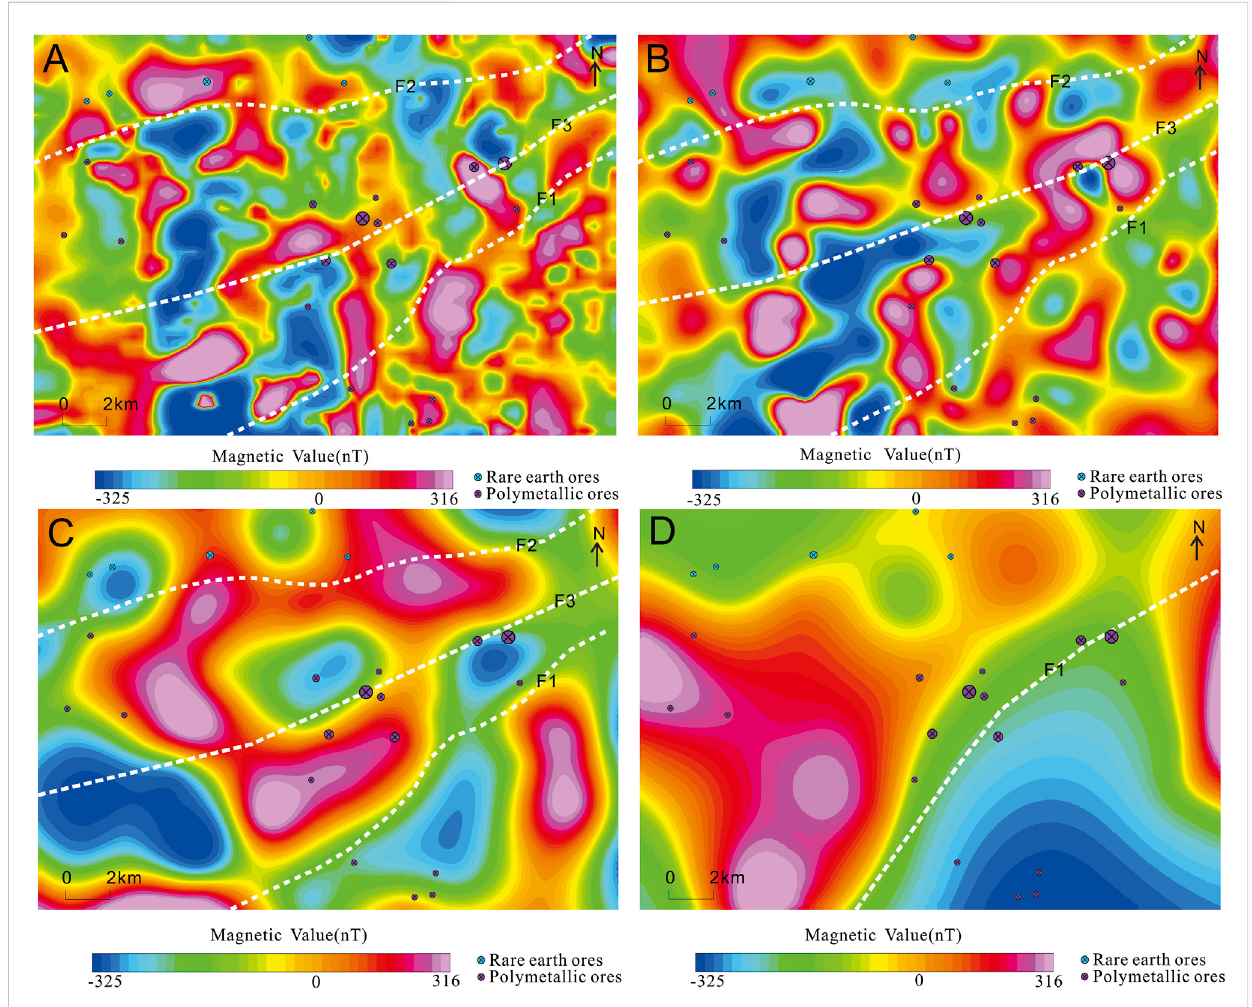
FIGURE 5 BIMFs and RES decomposed from RTP anomaly: (A) BIMF M1 image (B) BIMF M2 image; (C) BIMF M3 image (D) RES M image. White lines are faults interpreted by BIMFs and RES.